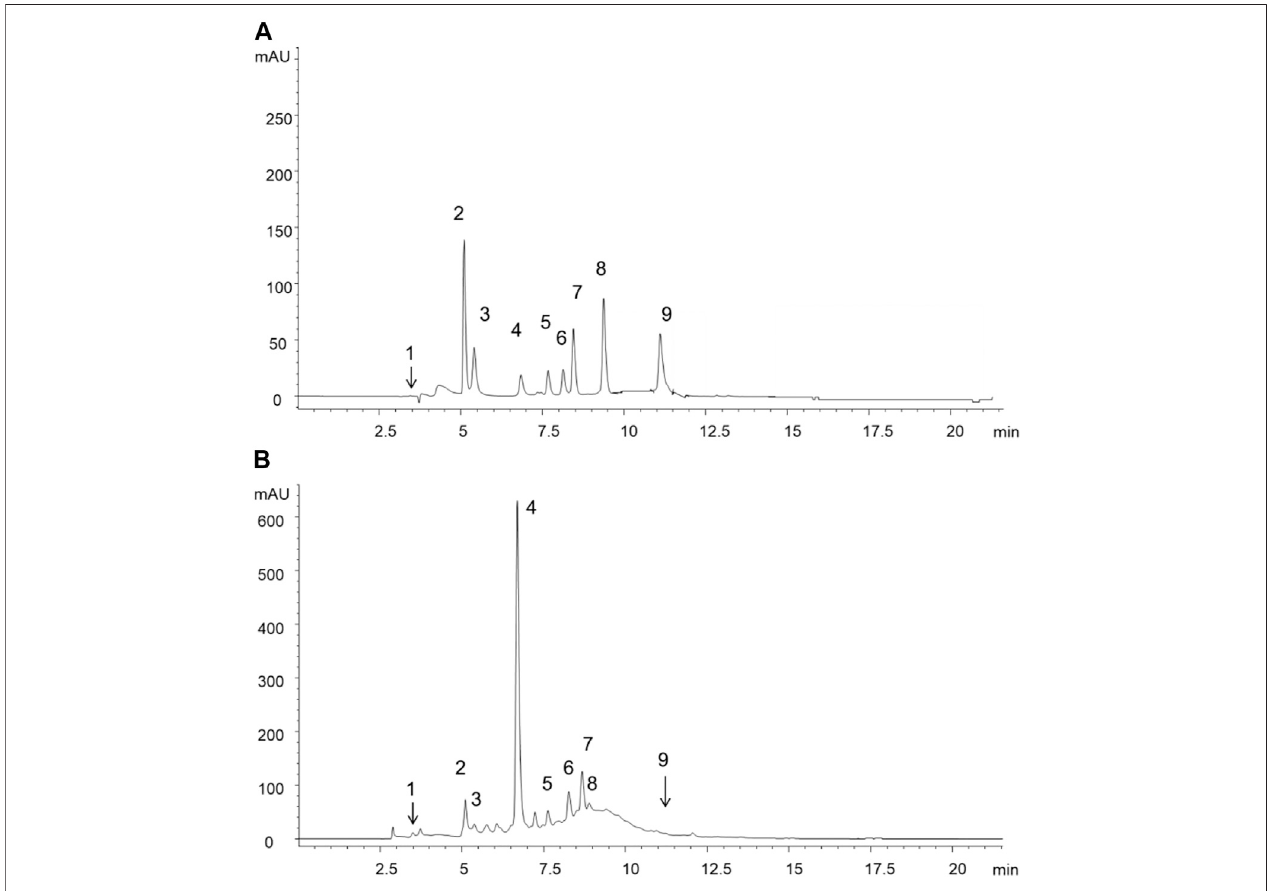
FIGURE 1 | HPLC-DAD chromatograms reported only at 272 nm for sake of clarity and corresponding to (A) standard mixture solution (B) extract of methanolic fronds extract of Polypodium vulgare L. List of compounds: 1 (cid:2) shikimic acid, 2 (cid:2) gallic acid, 3 (cid:2) 5-O-caffeoylquinic acid, 4 (cid:2) 3-O-caffeoylquinic acid, 5 (cid:2) catechin, 6 (cid:2) epicatechin, 7 (cid:2) rutin, 8 (cid:2) hyperoside, 9 (cid:2) 3,5-di-O-caffeoylquinic acid.